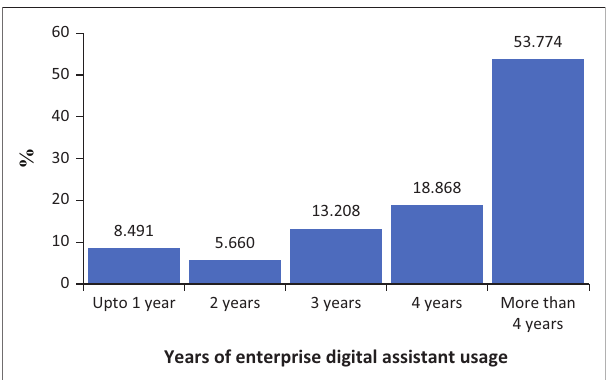
FIGURE 4: Distribution of years of enterprise digital assistant usage.